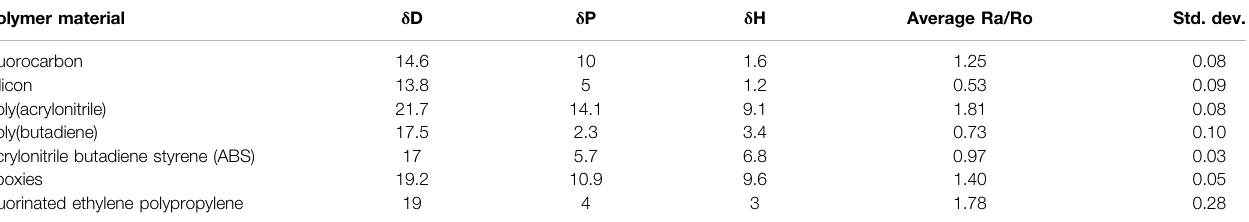
TABLE 6 | Hansen Solubility Parameters, average Ra/Ro, and standard deviations for the polymers and cycloalkane data set analyzed in this work. Standard deviations are very low, indicating that most cycloalkanes either exhibit o-ring swelling, or do not. HSP data taken from Accu Dyne Test. Polymer